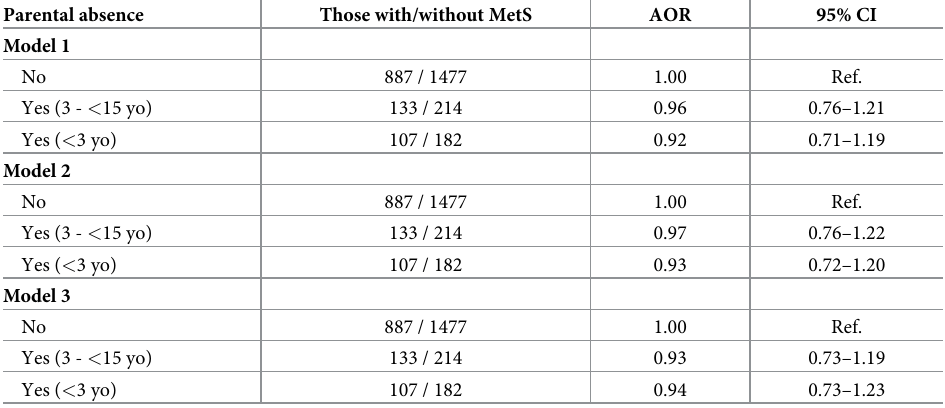
Table 2. Logistic regression analyses for the association between parental absence in childhood and metabolic syn- drome in adulthood among study participants in the Khanh Hoa Cardiovascular Study, Vietnam (2019–2020). Parental absence Those with/without